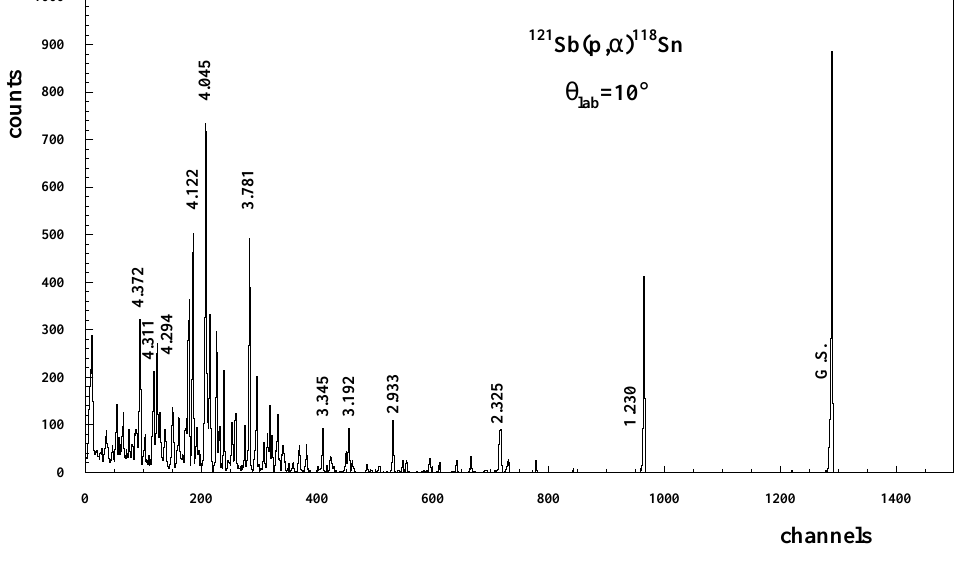
Fig. 2. Energy spectrum of α particles measured at 10 o for the 121 Sb( p ,α ) 118